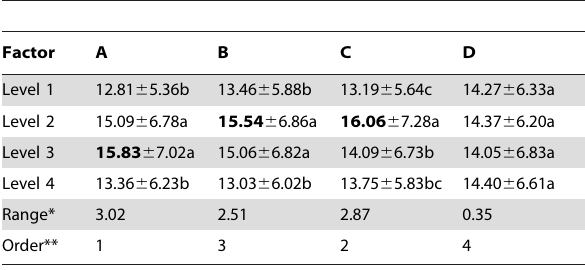
Table 4. Average responses of each level and range of Radicular length (mm). N=400.